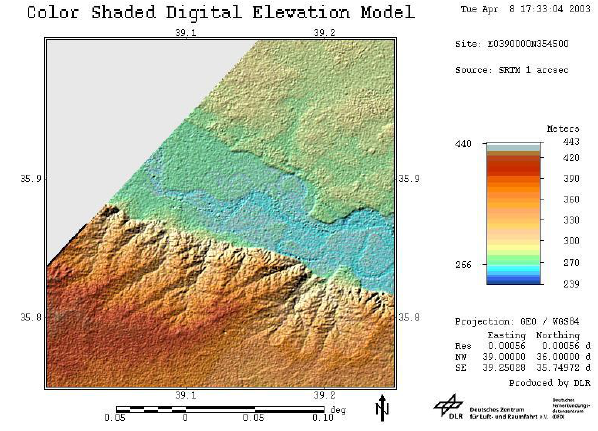
Figure 4. DEM tile from X-SAR shuttle mission 2000 showing parts of Jebel Bishri and the Euphrates river valley. The data was provided German Aerospace Centre.